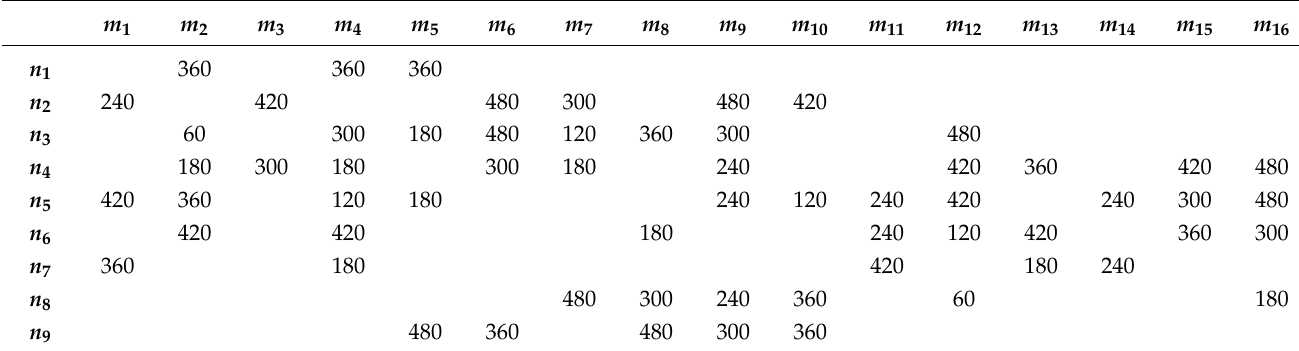
Table 15. Distance travelled for Variant #3 (km).